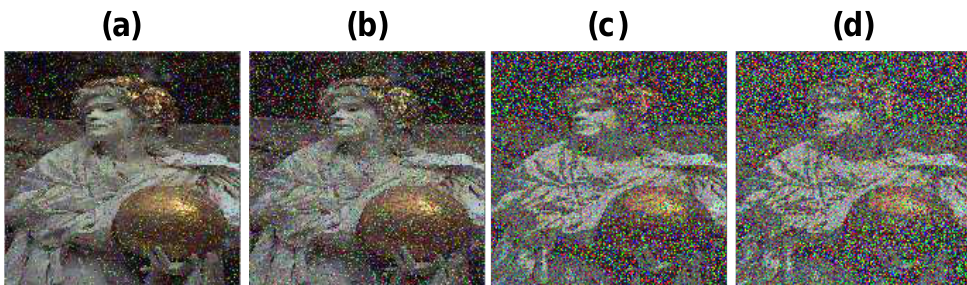
Figure 15. Resistance against Gaussian noise on the image in Figure 2f: ( a – d ) images obtained by Gaussian noise with mean = 0 and variance of 0.001, 0.002, 0.01, and 0.02,